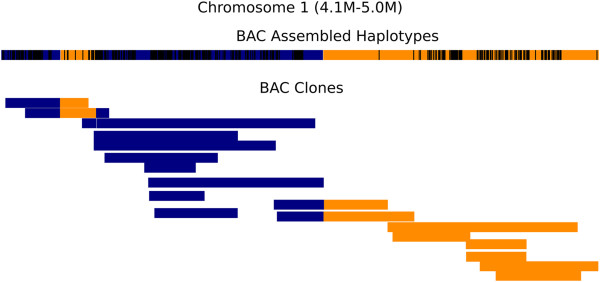
Consistency between BAC-assembled haplotypes and BAC clones. A snapshot of a 1 Mbp region on chromosome 1 illustrating three switch errors between BAC-assembled haplotypes and the population-based haplotypes (indicated by three color changes along the haplotype). At all three switches, 100% of the BAC clones that span this switch are consistent with the BAC-assembled haplotypes. The heterozygous variants that are phased are represented as black vertical lines in the BAC-assembled haplotypes.